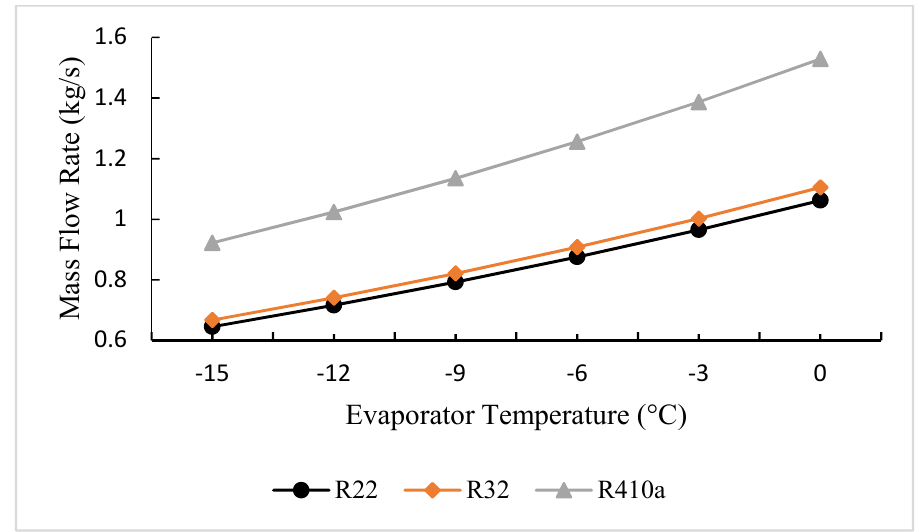
Figure 5. Variation of COP and cooling capacity versus evaporating temperature at constant con- denser temperature 60 ℃.